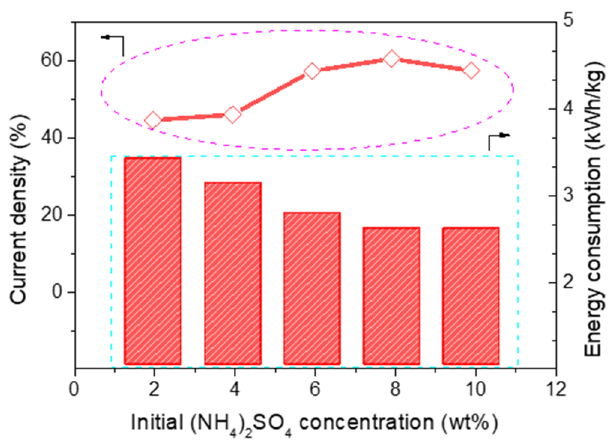
Figure 7. The change of current efficiency and energy consumption with different concentrations of (NH 4 ) 2 SO 4.